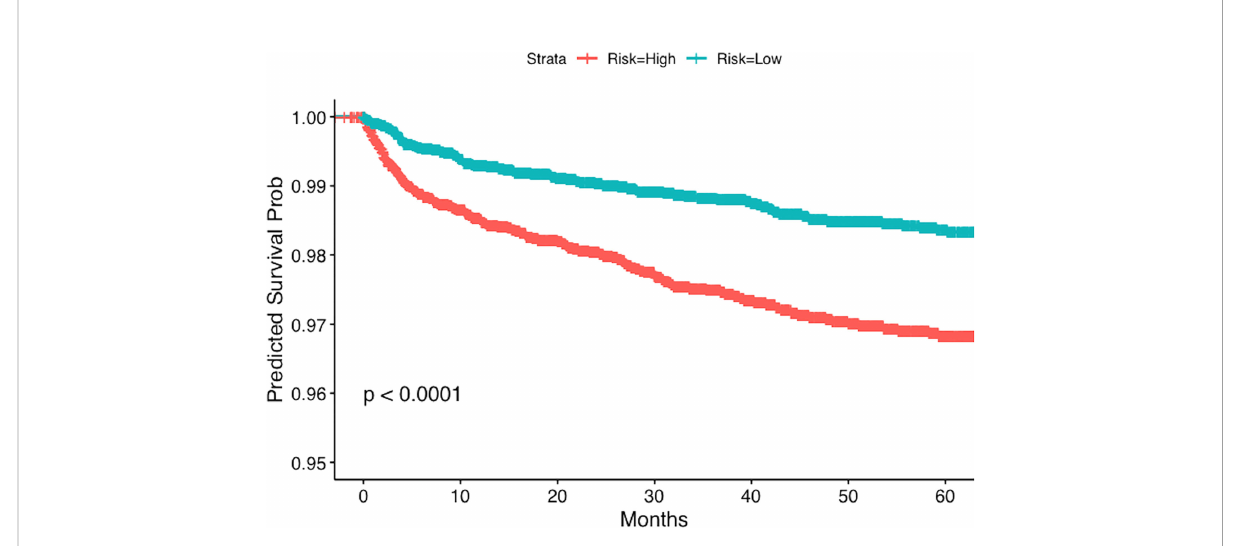
FIGURE 1 Kaplan-Meier plot for the time to PE from the time of diagnosis of GCA strati fi ed by predicted risk (blue and red lines)